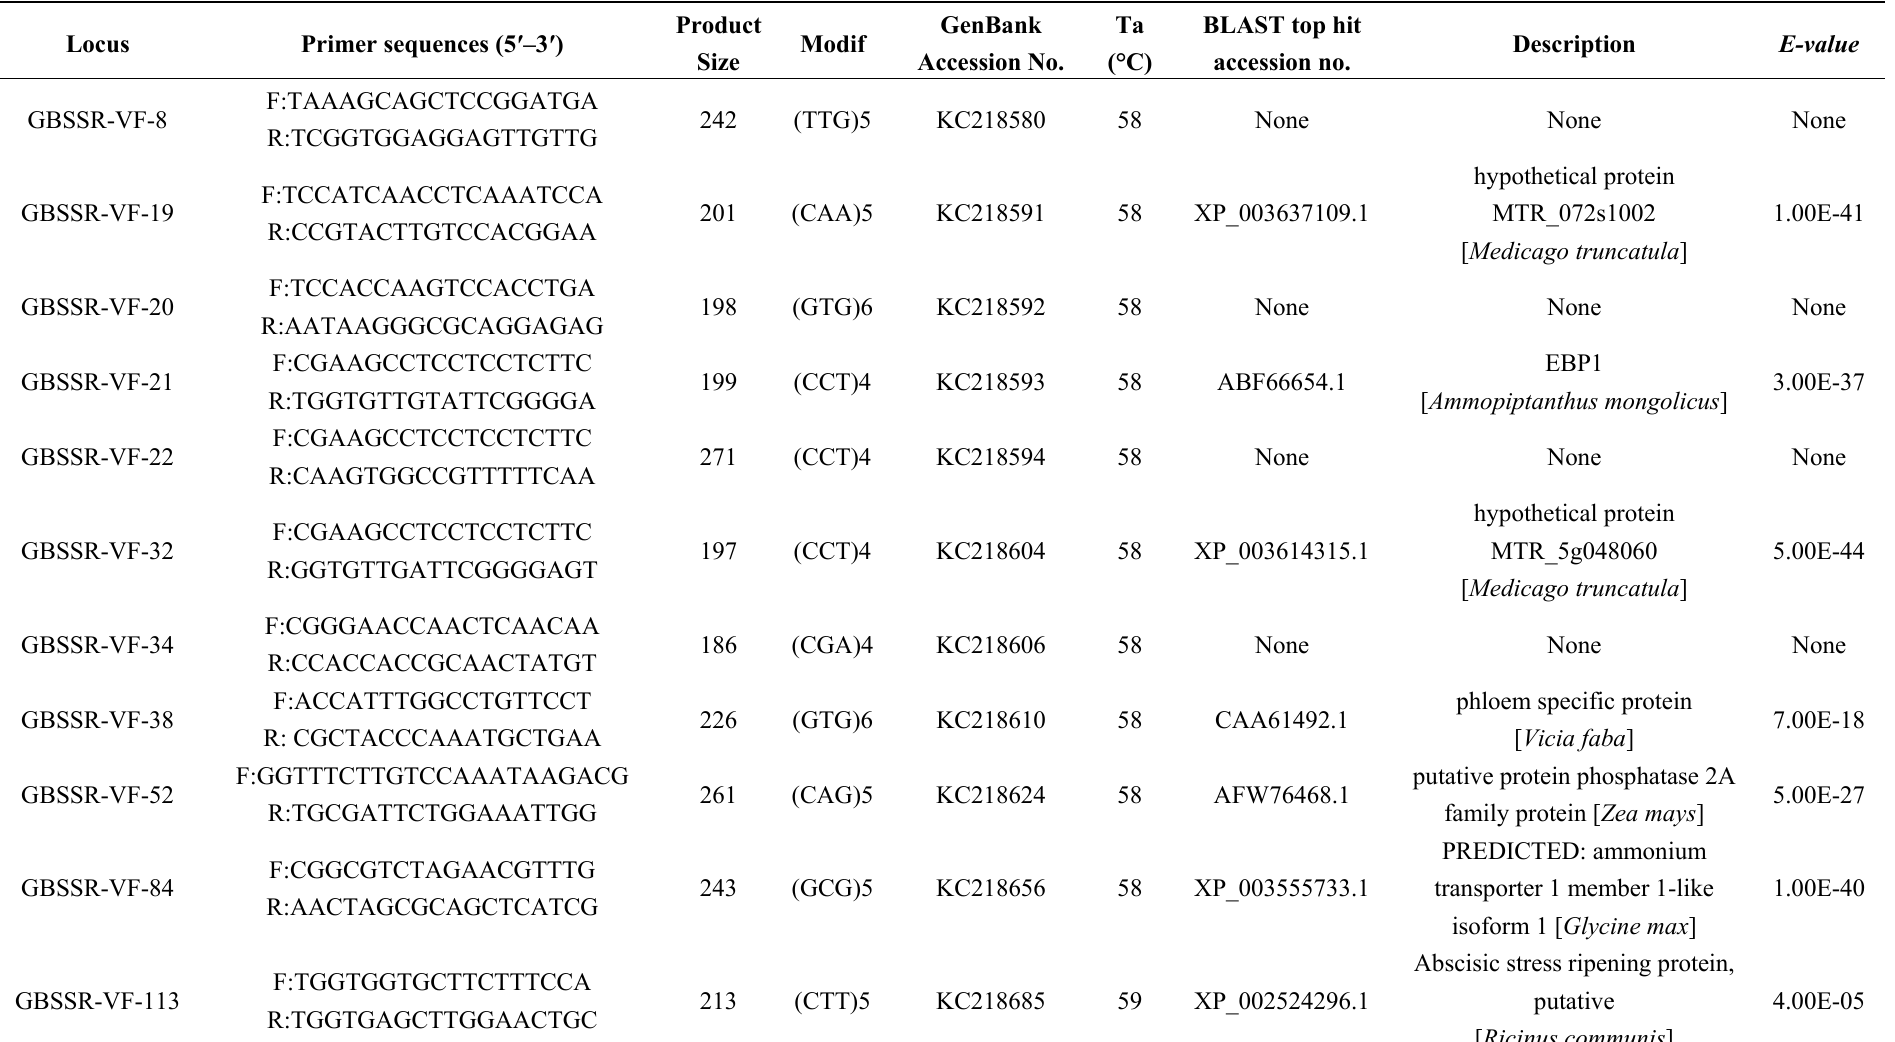
Table 1. Characteristics of the 55 cDNA-SSR markers for faba bean ( Vicia faba